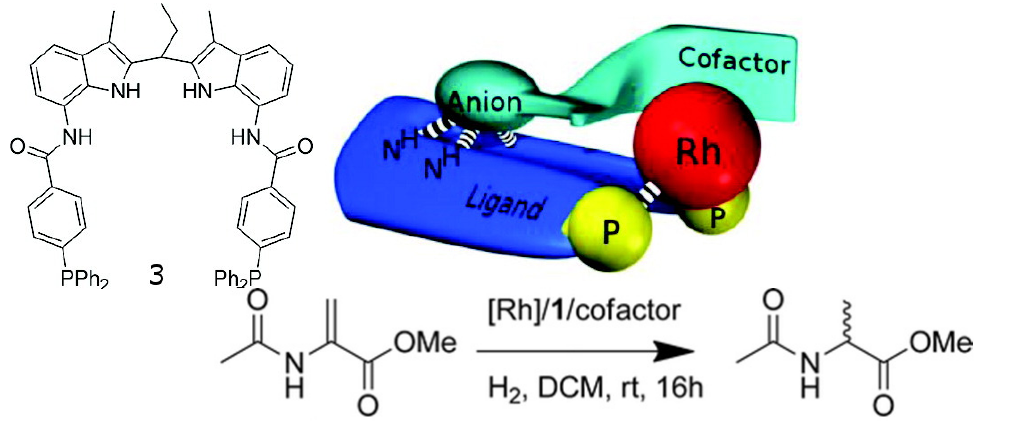
prochiral Substrate chiral product (single